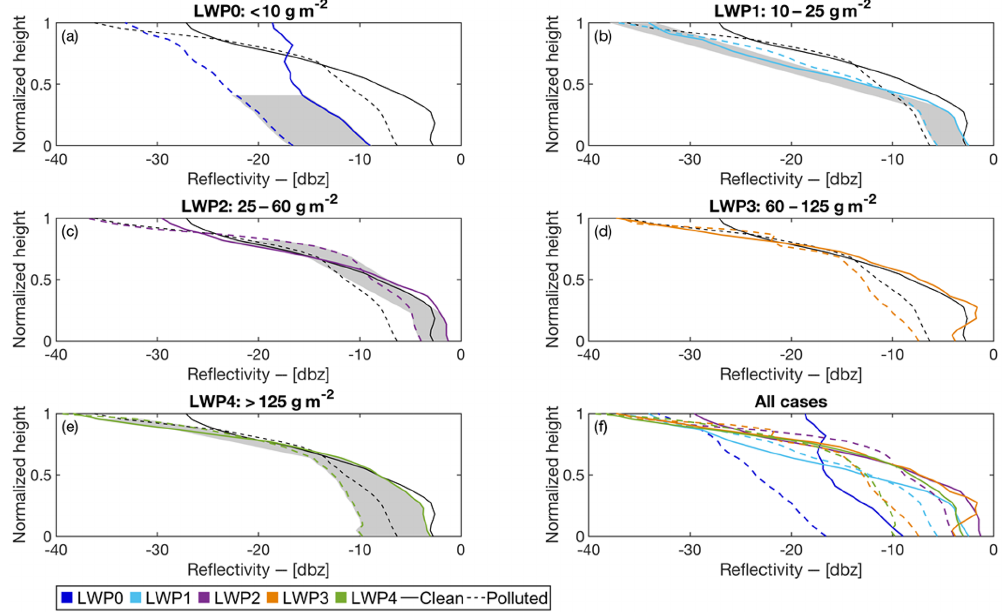
Figure 1. Reflectivity profiles for the five LWP regimes for (a) LWP0, (b) LWP1, (c) LWP2, (d) LWP3, (e) LWP4 and (f) all LWP bins. Zero (0) corresponds to cloud base, and 1 corresponds to cloud top. Dashed lines represent polluted clouds, and solid lines indicate clean cases. The black lines, shown for reference in each panel, represent the mean profiles for the combined LWP bins. Grey shading represents regions of the cloud layer where there is a statistically significant difference between the clean and polluted reflectivity